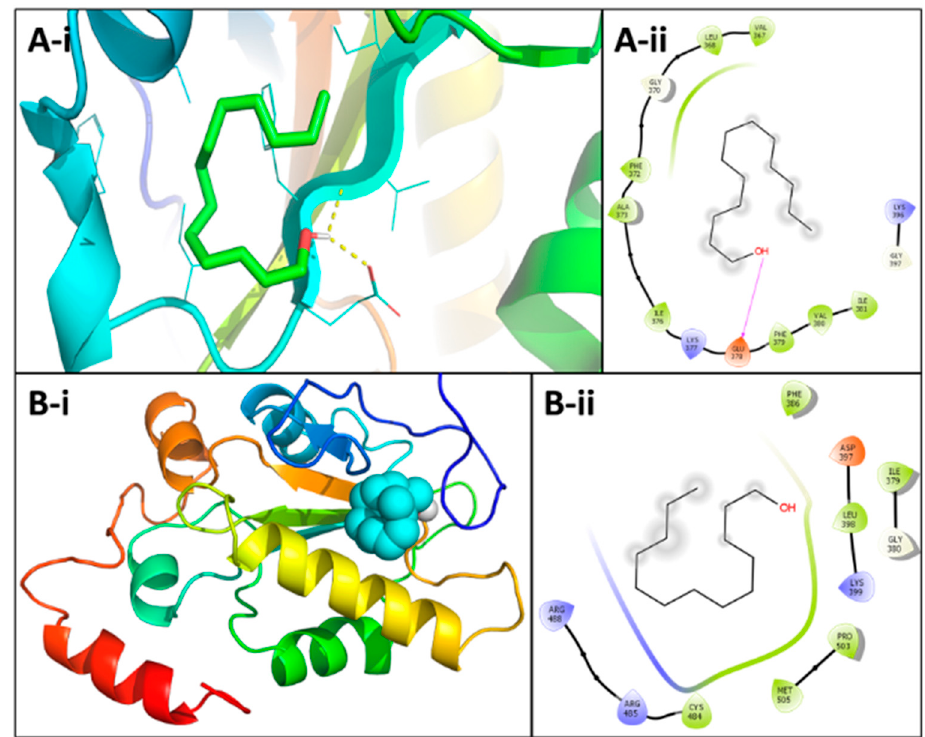
Figure 4. Molecular docking ( A-i ). The mode of interaction of compound 2-tridecen-1-ol in the ac- tive region of CDC25B ( A-ii ). The ligand 2-tridecen-1-ol (green colored) ( B-i ) and the important ( A-ii ). The ligand 2-tridecen-1-ol (green colored) ( B-i ) and the important residues in the active site of the enzyme are residues in the active site of the enzyme are presented by a tube model ( B-ii ). presented by a tube model ( B-ii